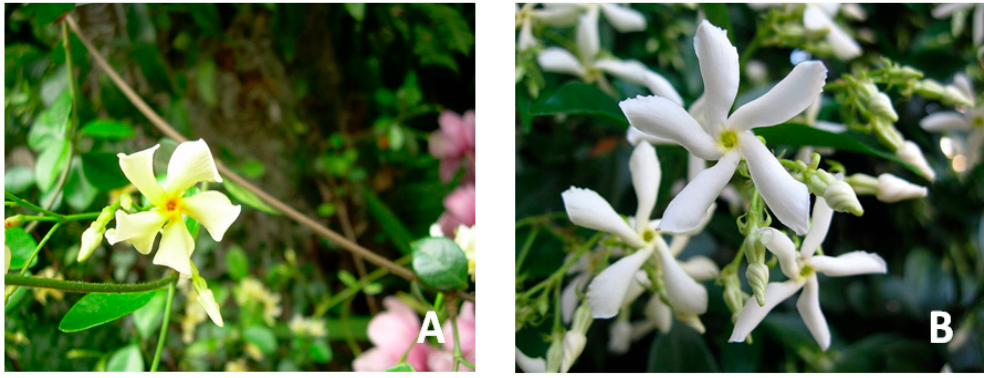
Figure 1. Trachelospermum plants: ( A ) T. asiaticum flowers and stems; ( B ) T. jasminoides flowers. (https://en.wikipedia.org/wiki/Trachelospermum) .